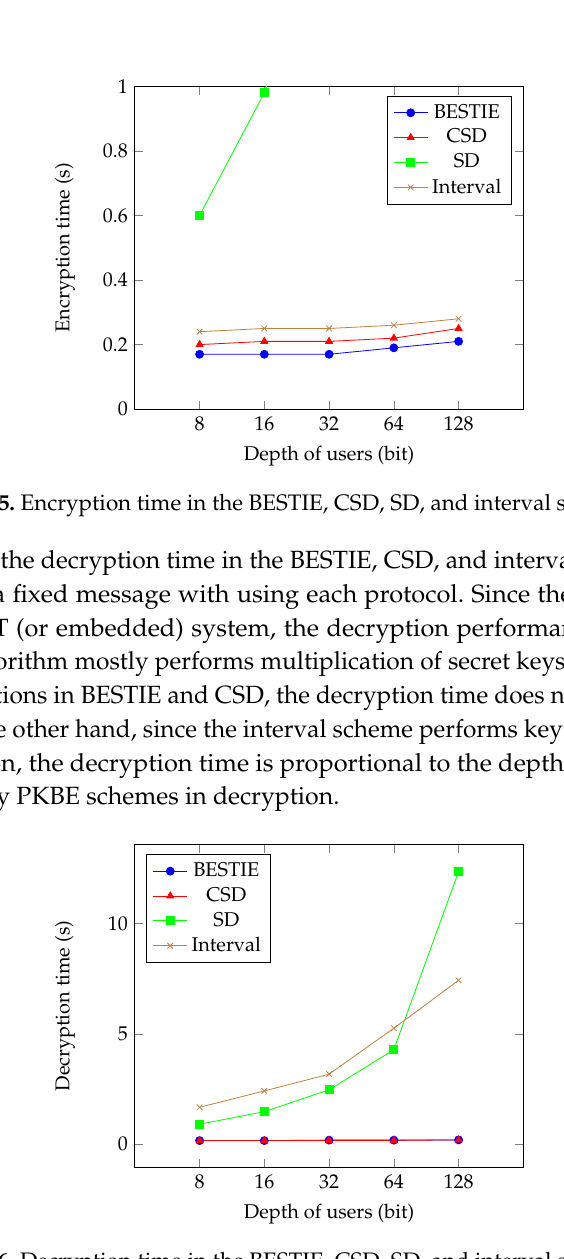
Figure 6. Decryption time in the BESTIE, CSD, SD, and interval